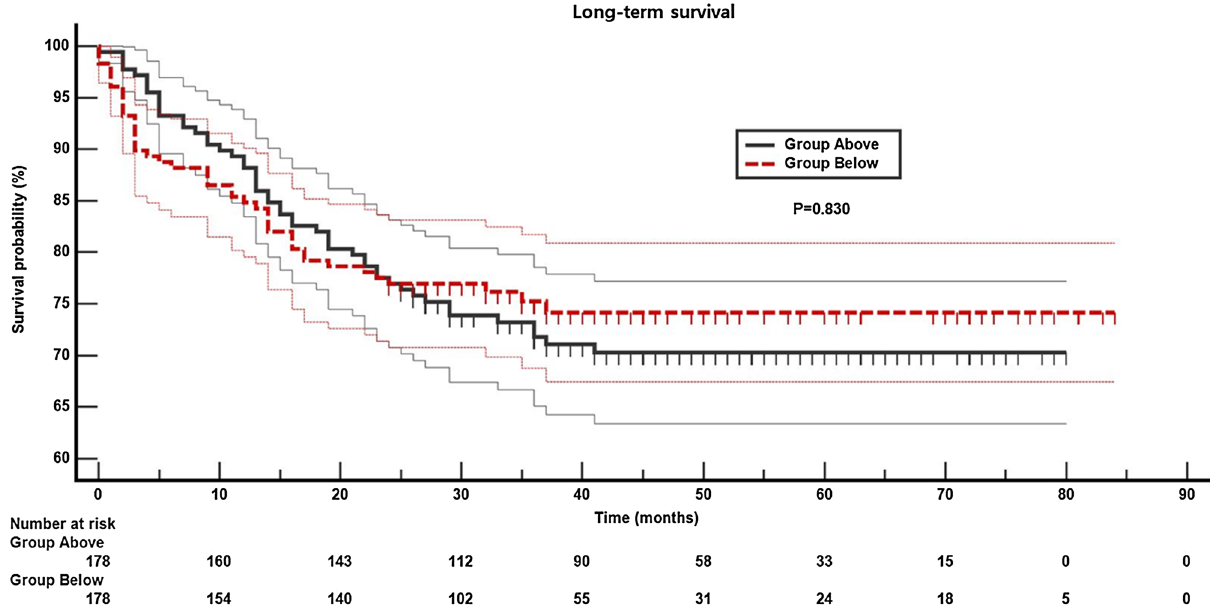
Figure 4. Kaplan–Meier survival analysis of the above (ppoDL CO ≥ 40% and ppoFEV 1 ≥ 40%) and below (ppoDL CO < 40% or ppoFEV 1 < 40%) groups in the propensity score-matched data. There was no difference between the two groups ( P = 0.830, hazard ratio 0.95, 95% confidence interval: 0.62, 1.47). ppoFEV 1 postoperative expiratory volume in 1 s, ppoDL CO diffusing capacity for carbon